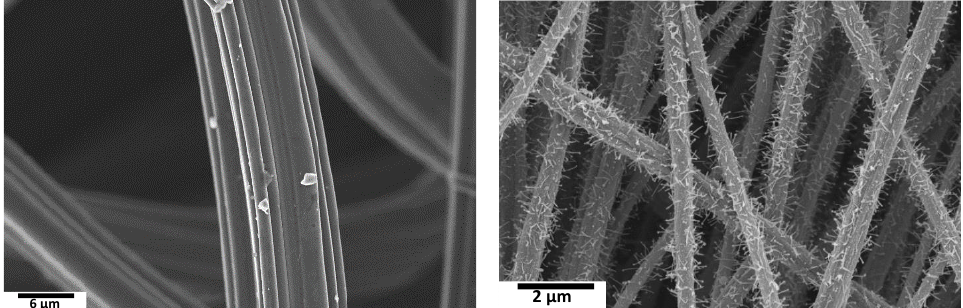
Figure 1. ( Left ) High resolution SEM of graphite felt. ( Right ) High resolution SEM of CCL.